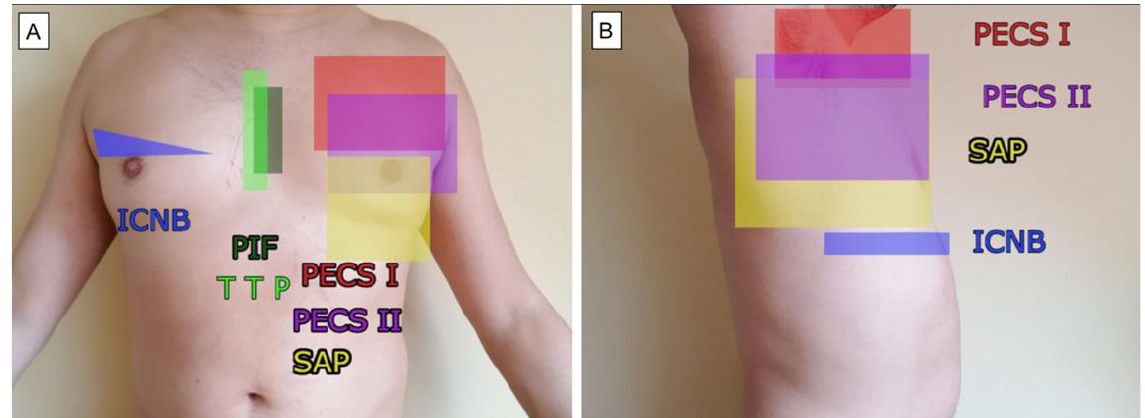
Figure 1. Approximate action areas for thoracic regional blocks: frontal ( A ) and lateral ( B )